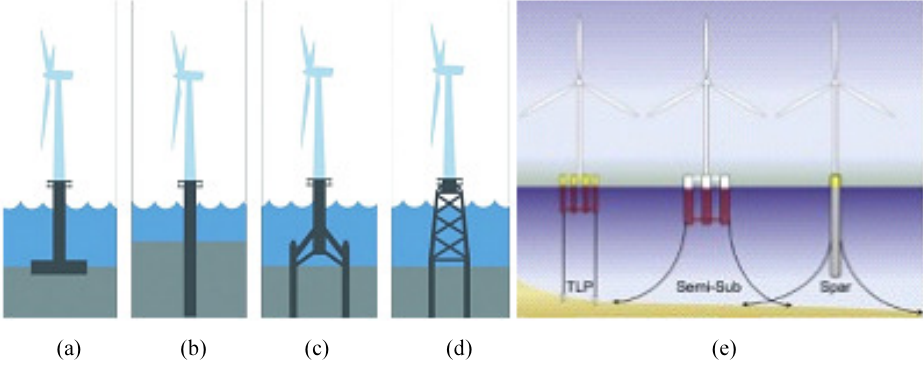
Fig. 1. The types of the foundations of the offshore wind turbine: a – gravity base structure, b – monopole, c – tripod, d – jacket structures, e – floating platform (First for Technology and Innovation